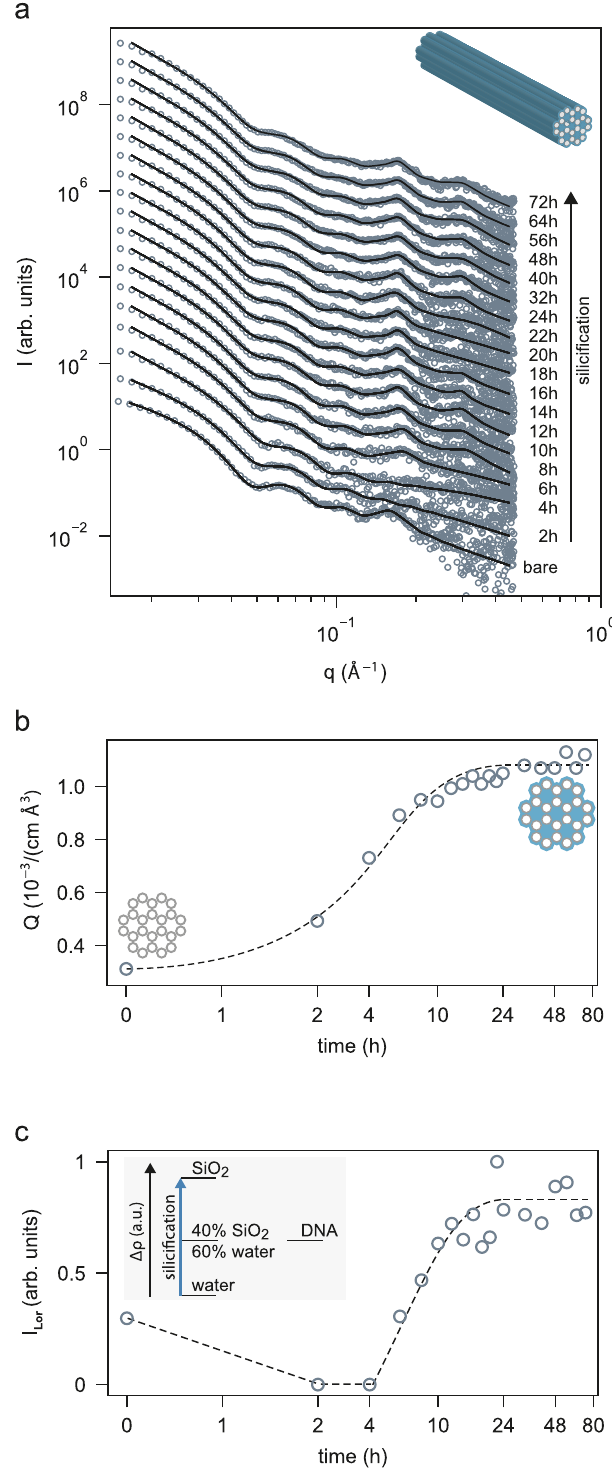
Fig. 1 | In situ silici fi cation of 24HBs while tumbling with constant speed (50rpm) monitored by SAXS. SAXS data is recorded for bare 24HB and during silici fi cation ( a ). The data is shown together with the best fi ts of a cylinder model together with Lorentzian peaks accounting for the inner honeycomb lattice arrangement. Lorentzian peaks are highlighted by dashed lines. Data is scaled for clarity. Model-free Porod invariant Q ( b ) as a measure of the overall scattering contrastandnormalizedinterhelicalpeakintensities I Lor ( c )are extractedfromthe SAXS data shown in ( a ) as function of silica growth time. 24HB shape with honey- comb lattice structureisshown inthe inset. Dashed line serves asguideto the